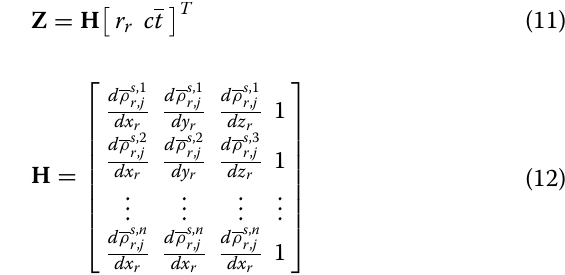
pler positioning performance in harsh environments.